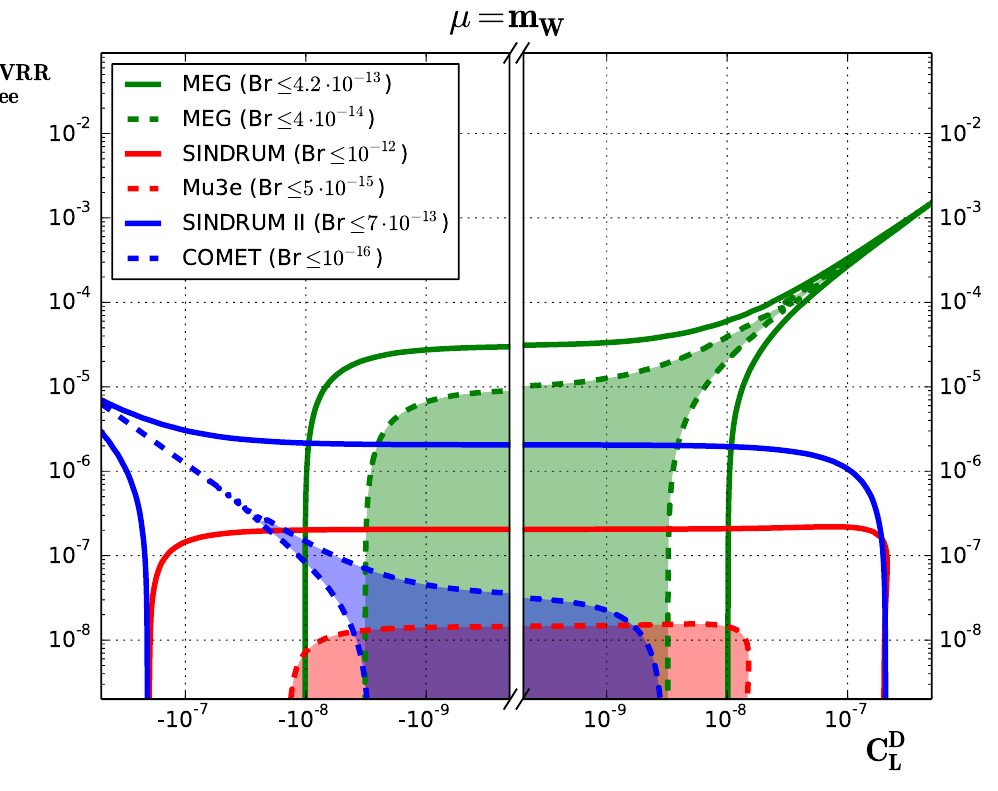
Figure 5. Allowed regions in the C D conversion (blue) for current (straight) and future (dashed) experimental